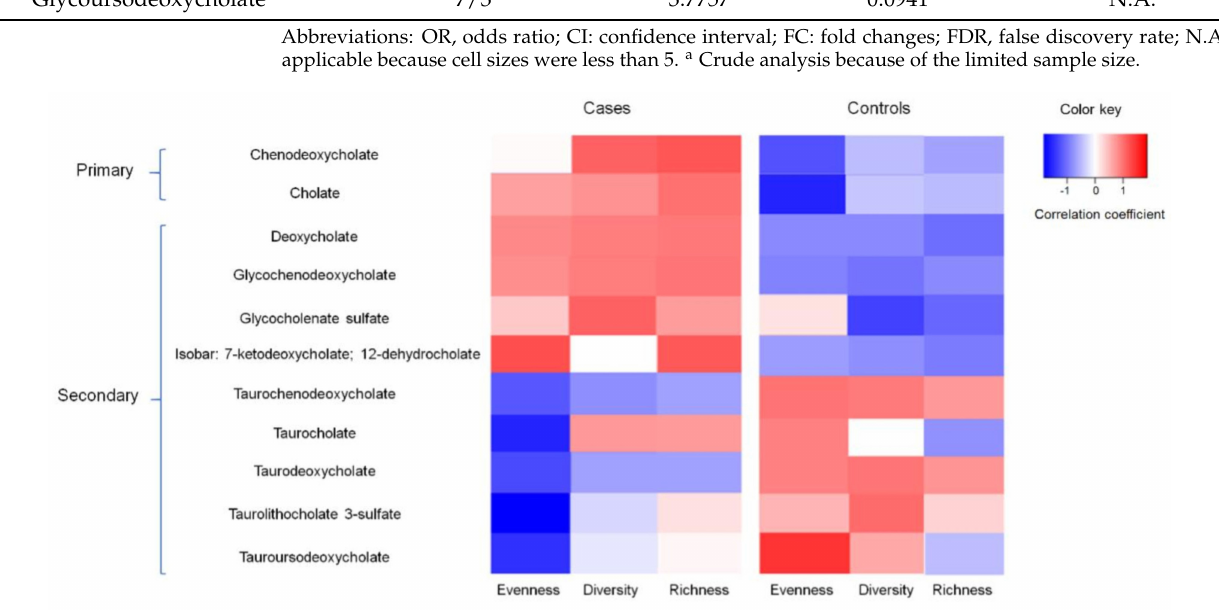
Figure 1. Correlation between secondary bile acid concentration and gut bacterial evenness, diversity, and richness among cases and controls, Diet and Health Study V, 2008–2010 (subset n =